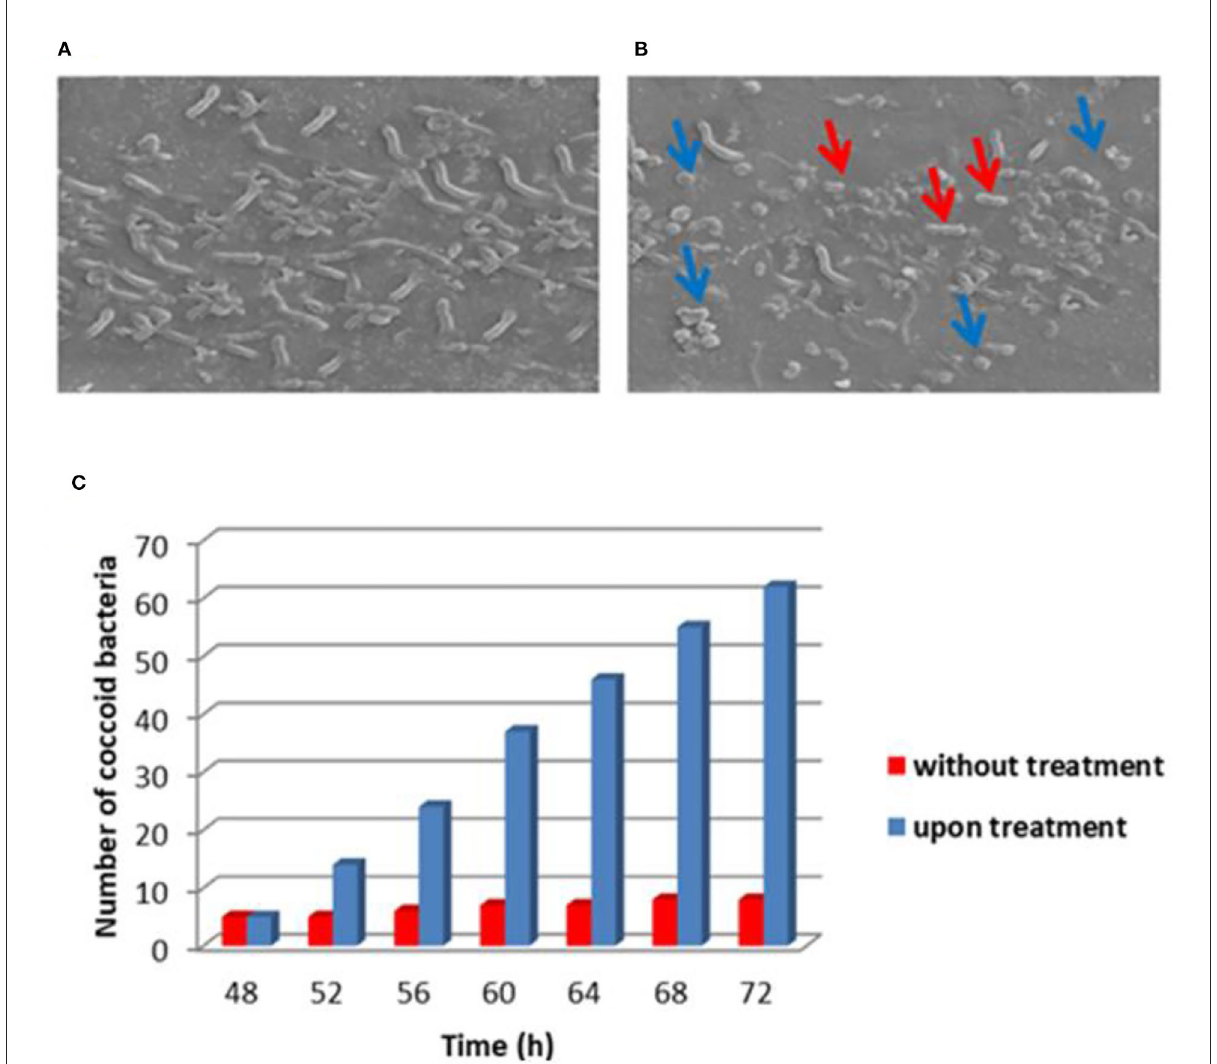
FIGURE2 Electron microscopy image of Helicobacter pylori NCTC 11638 strain untreated (A) and treated (B) with asclepain cI. Histogram with statistical analysis of the number of coccoid cells (C)